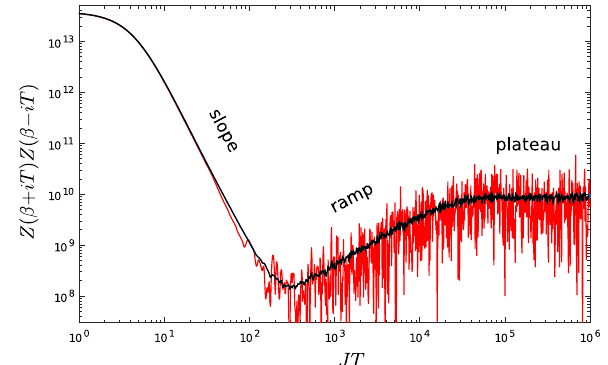
Fig. 1 A log–log plot [20] of the SYK spectral form factor for q = 4, N = 34, β J = 5. In red the time plot for a single realization of the disorder, wild erratic oscillations are quite visible in the ramp and the plateaupartsoftheplot.Oscillationsarewashedoutbydisorderaverage over a large enough number of samples without tough throwing away the main trend. Statistical average (in black) still exhibits an interested lack of information loss in the form of a random matrix universality. The black plot refers to numerics from an ensemble of 90 samples